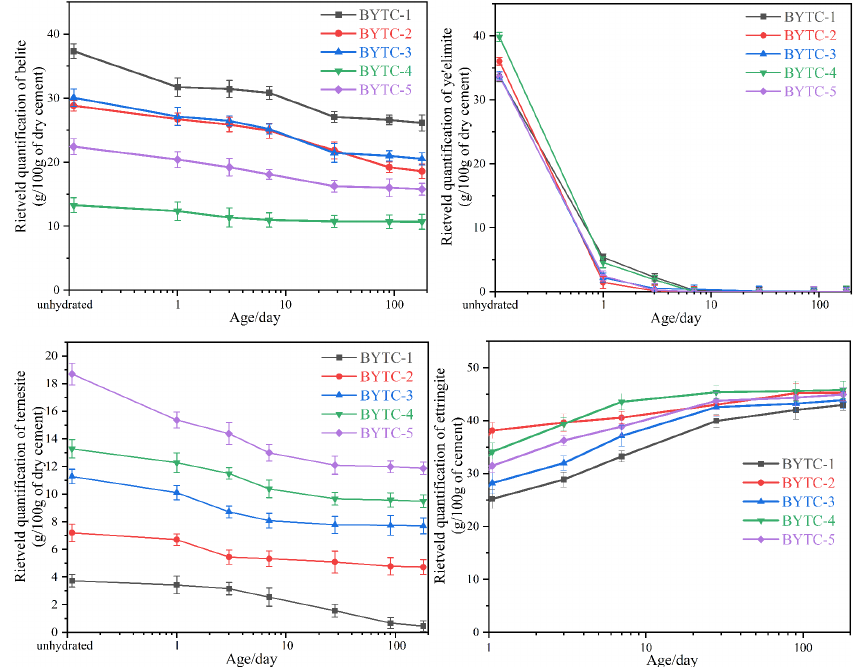
Figure 6. Evolution of belite, ye ′ elimite, ternesite and ettringite obtained by Rietveld refinement (measurement error is ±2%). Note: the y-axis scale is different.